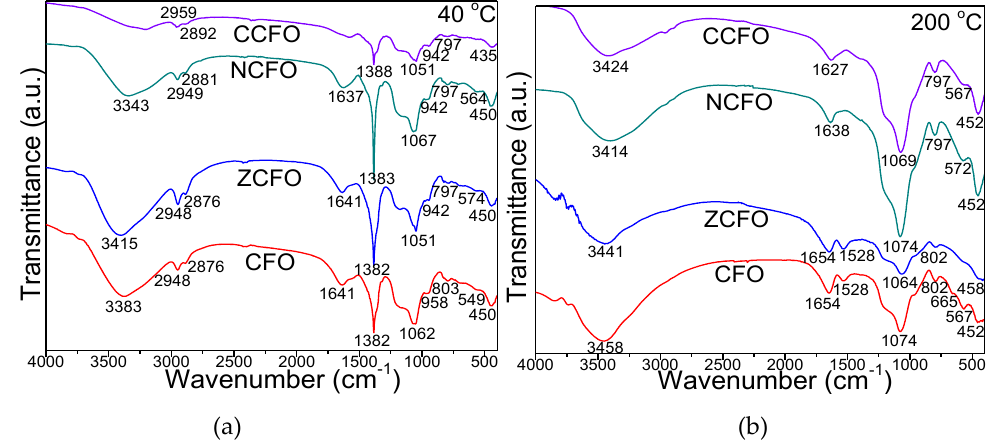
Figure 2. Fourier transform infrared spectra of CFO, ZCFO, NCFO, and CCFO samples heated at 40 ( a ) and 200 °C ( b ).